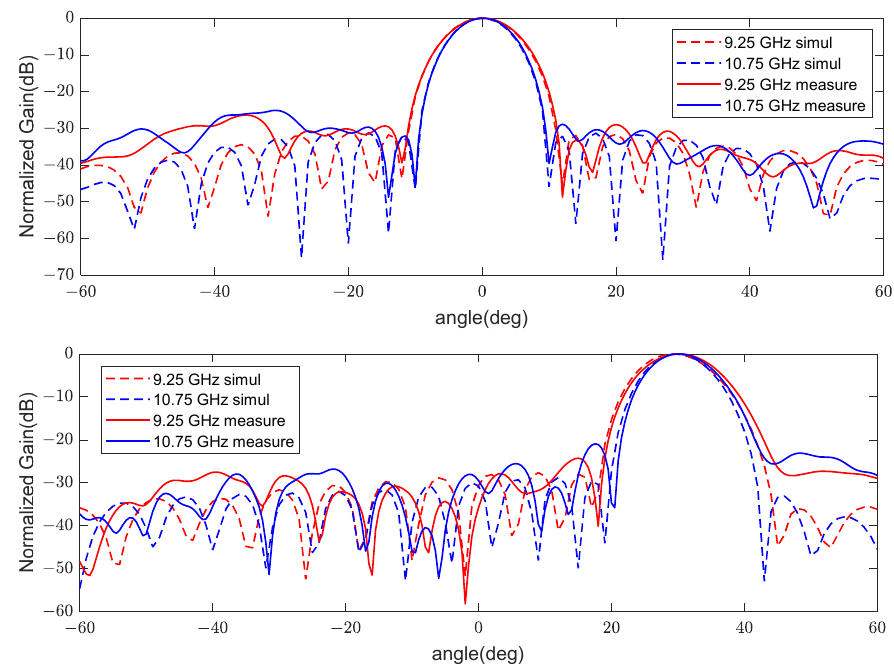
Figure 12. Beam pattern of antenna at the end frequencies (9.25 and 10.75 GHz) for steering angles of 0° ( up ) and 30° ( down ).